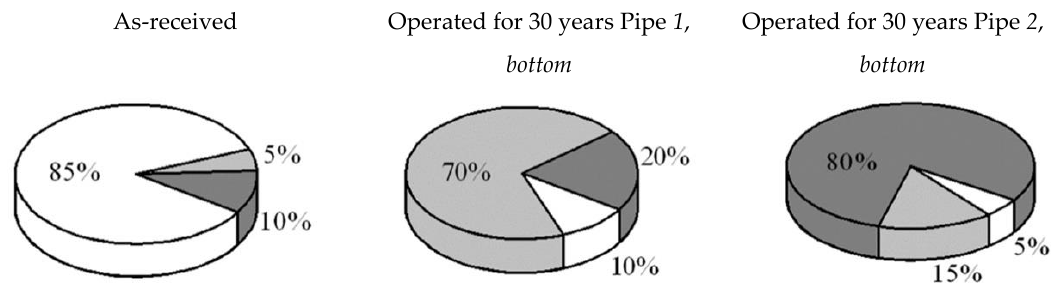
Figure 13. Hydrogen distribution in the X52 steel according to the results of vacuum extraction under different temperatures: 200 °C, 400 °C, 600 °C.